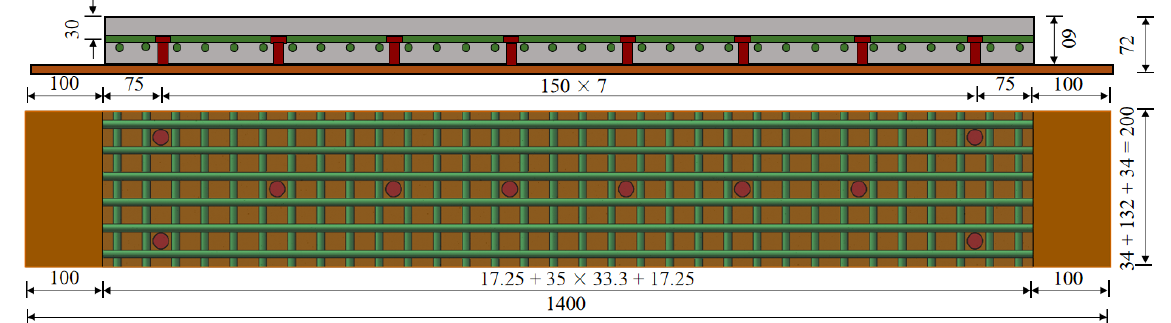
Figure 17. Structural diagram of specimen S150-60-25-6 (unit: mm).